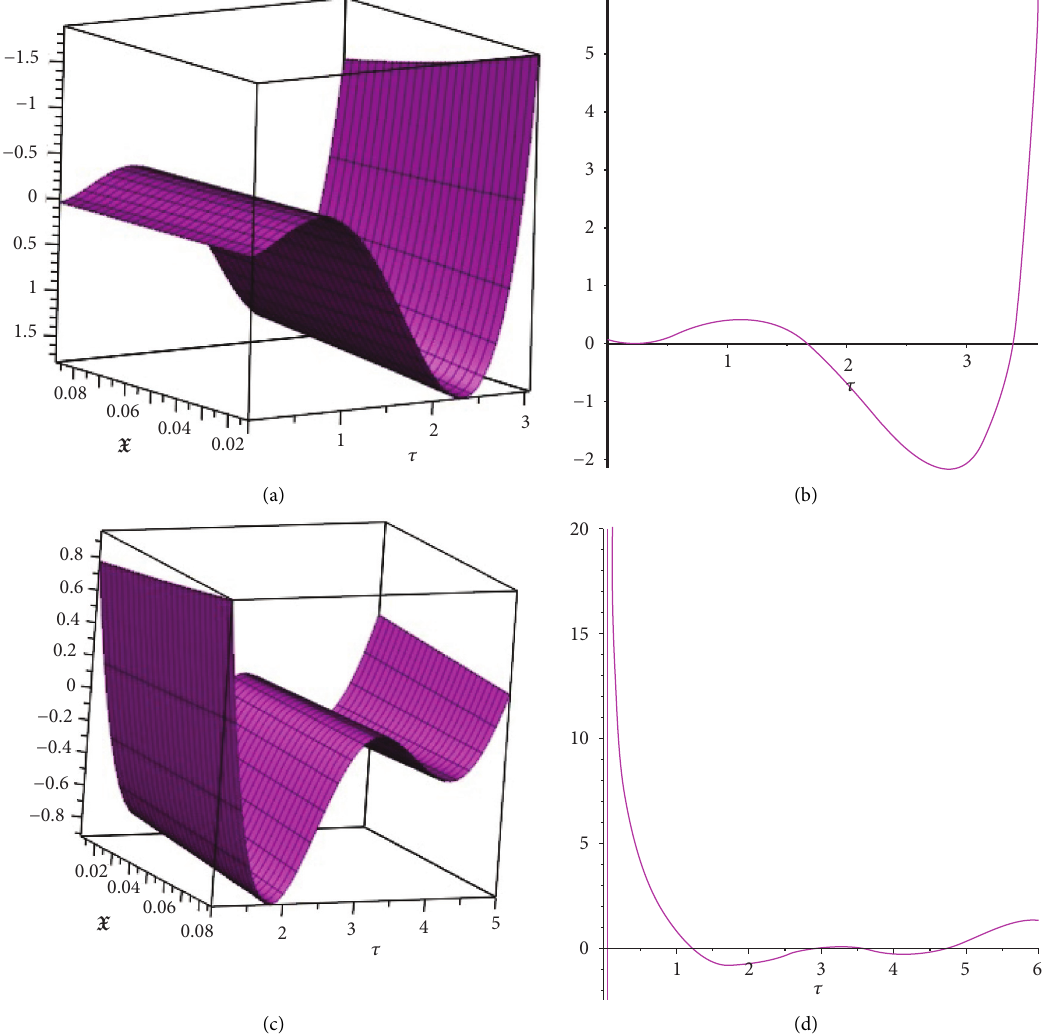
Figure 4: (a, b) 3D and 2D with the real part of solution Ψ under the values presented in Section